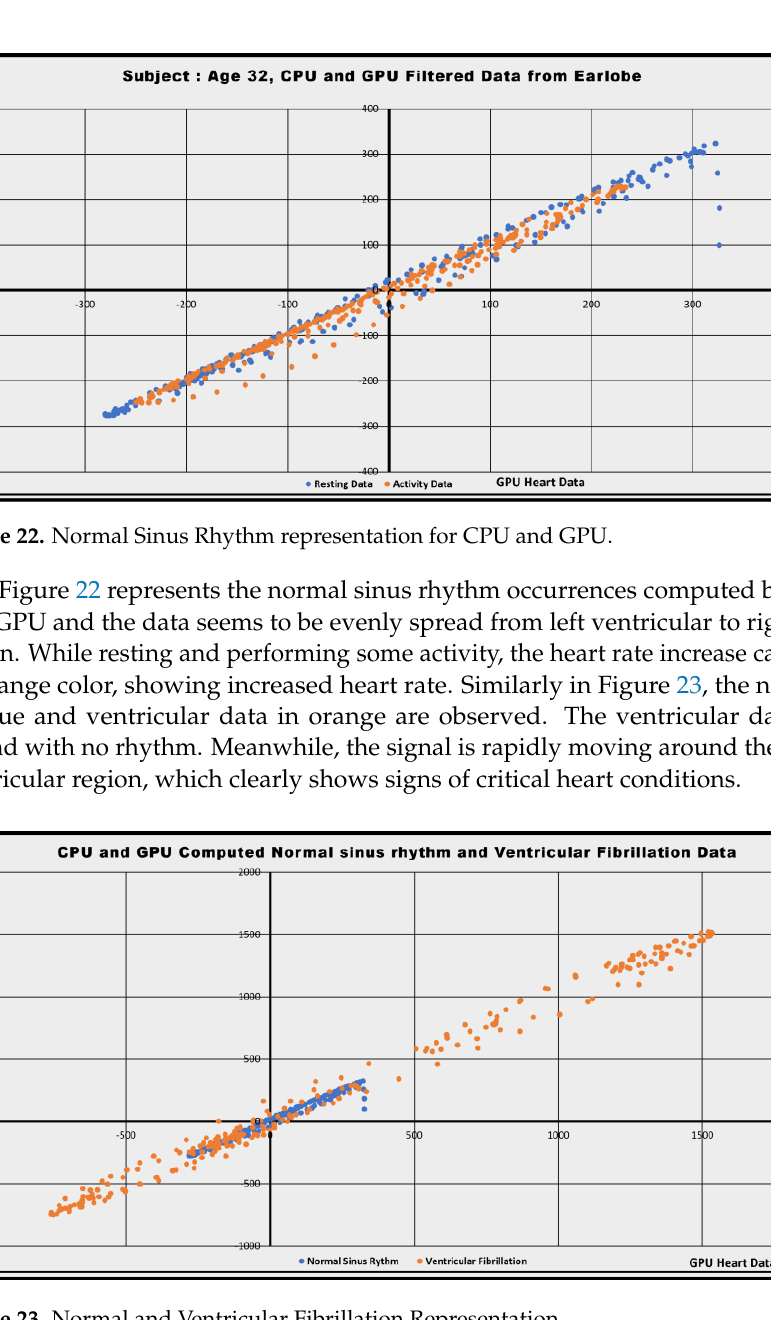
Figure 23. Normal and Ventricular Fibrillation Representation .